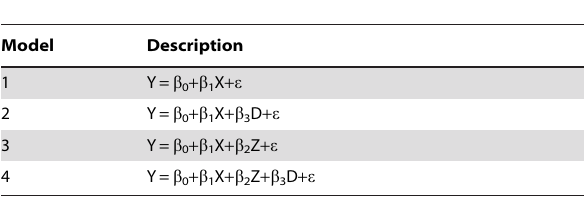
Table 1. Association models tested in this